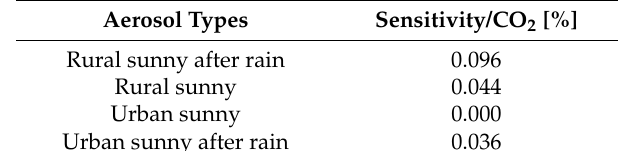
Table 4. Sensitivity to different types of aerosols.